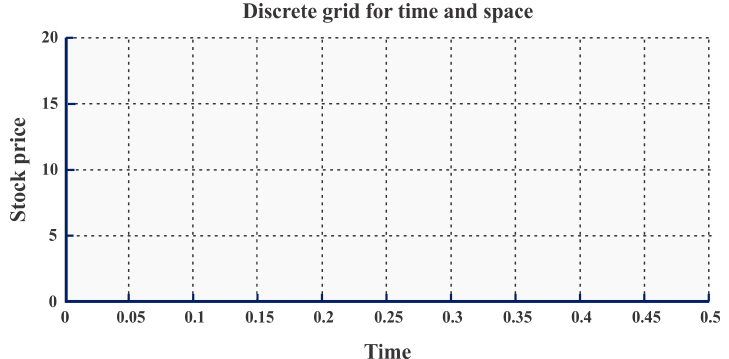
Figure 6. Discrete grid of time and